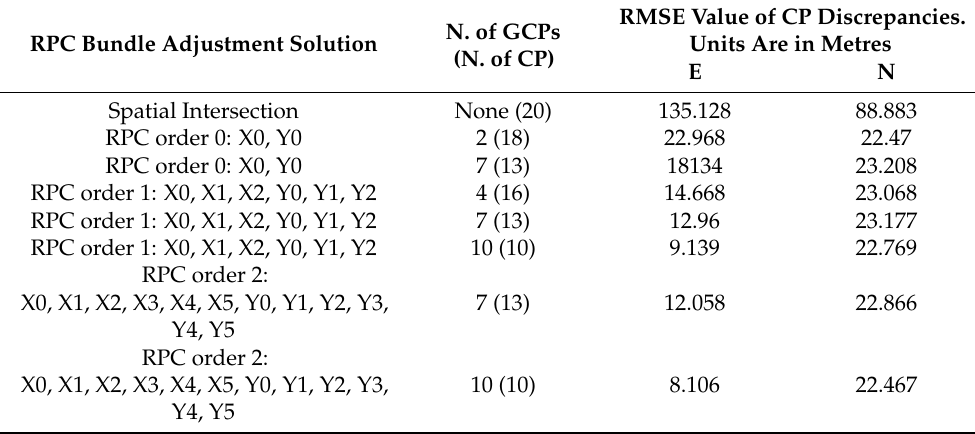
Table A1. Results of RPC bundle adjustment with bias compensation for strip in E-W direction, Rome test field.